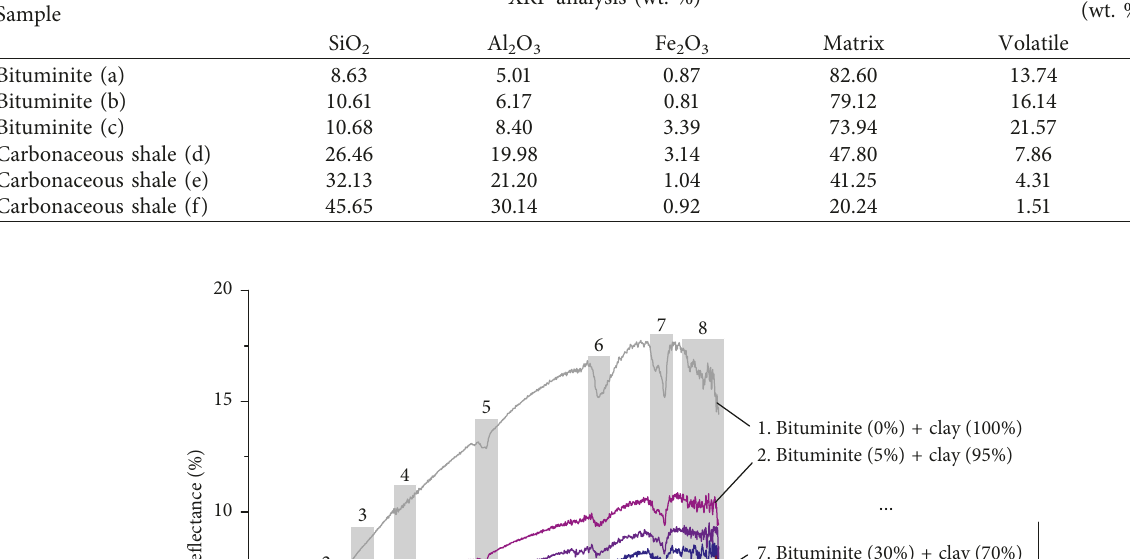
Table 2: X-ray fluorescence (XRF) and proximate analysis of samples in Figure 1. XRF analysis (wt. %) Sample